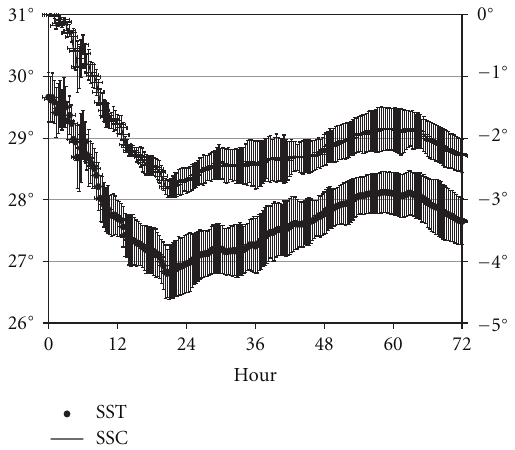
Figure 4: Time series of the mean di ff erences in SST ( ◦ C; left axis) and SSC ( ◦ C; right axis) between NCM and NHM values averaged over the nine experiments and their standard